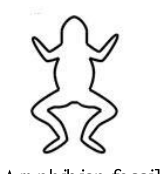
Figure 1 . Amphibian fossil symbol.